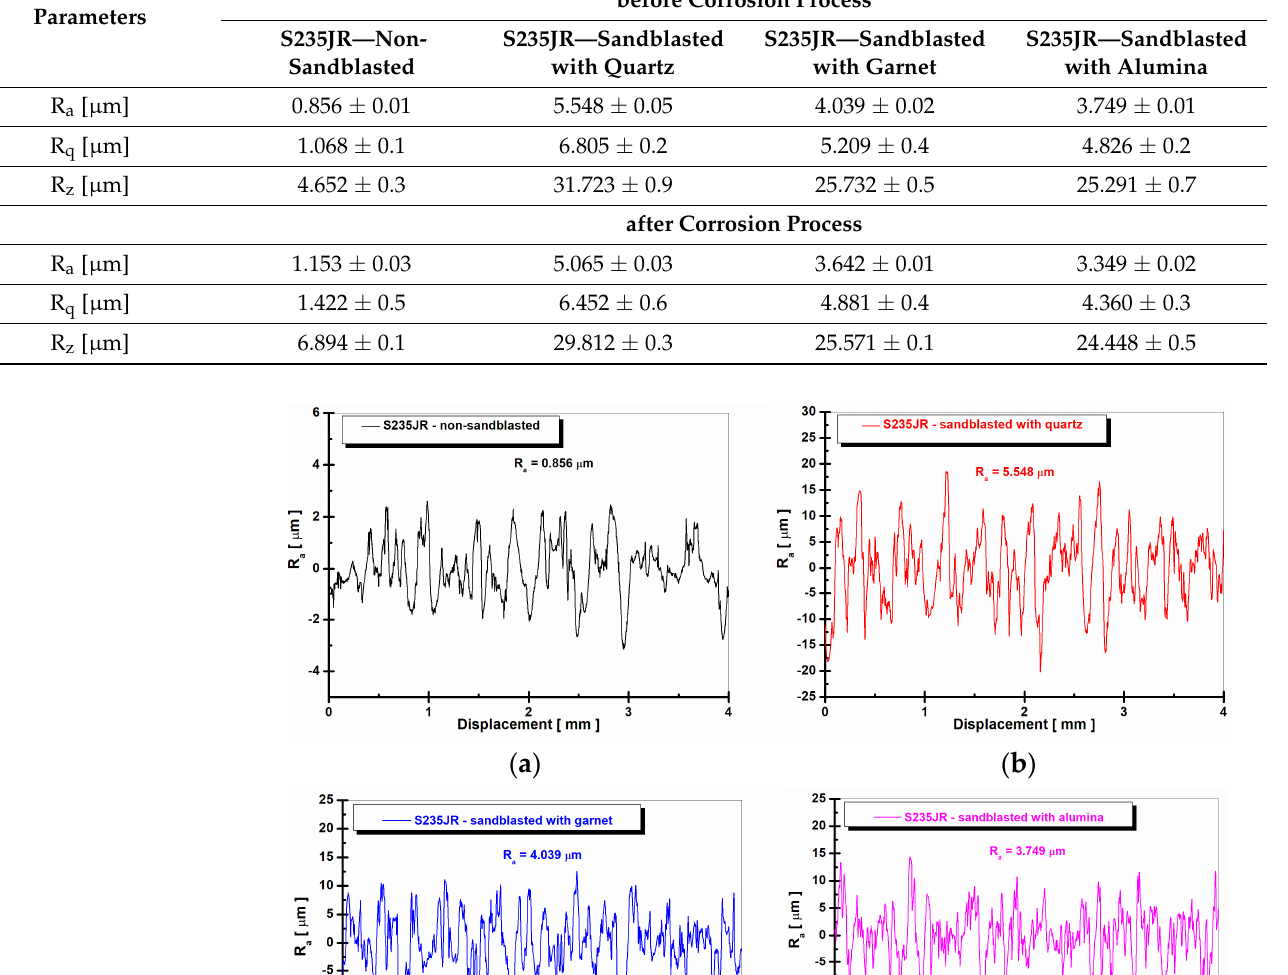
( d ) Figure 7. 2D surface profile of surface roughness after corrosion of S235JR immersed during 336 h in 3.5 NaCl solution for: ( a ) S235JR—non ‐ sandblasted, ( b )—S235JR—sandblasted with quartz, ( c )— S235JR—sandblasted with garnet, ( d )—S235JR—sandblasted with alumina. Table 5. Roughness parameter values for the tested surfaces before and after the corrosion pro ‐ cess. Parameters